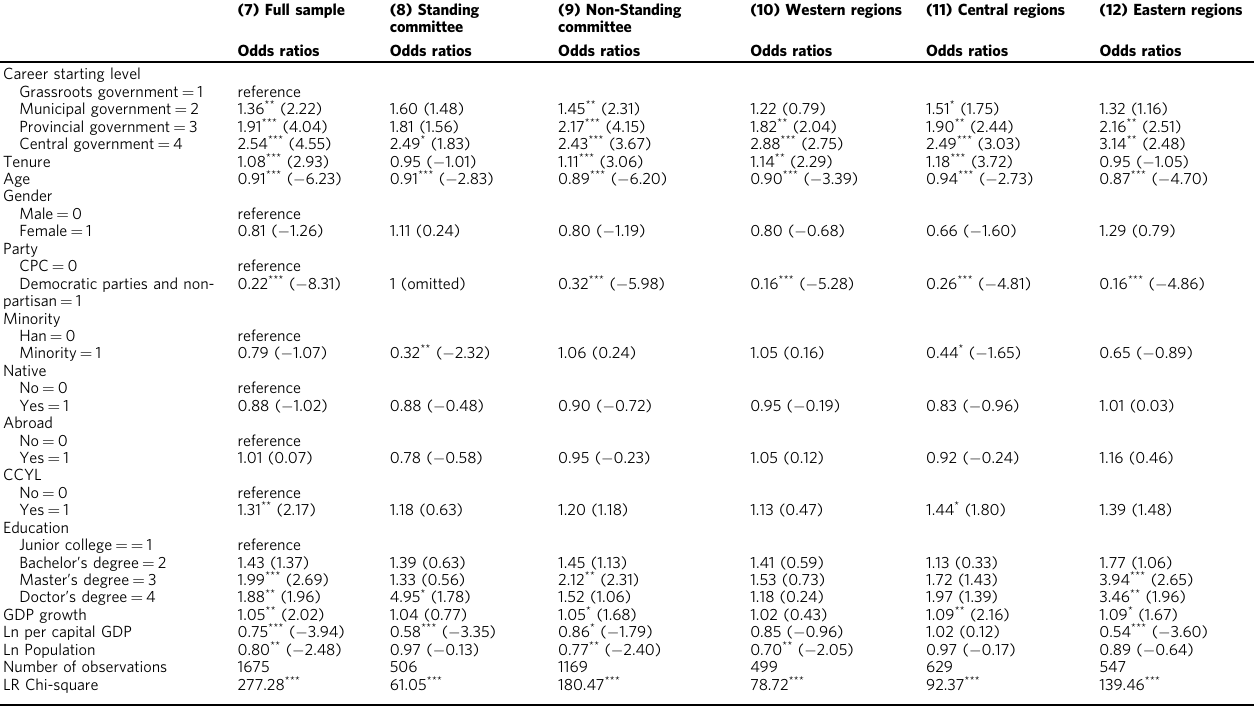
Table 3 The logistic regression results estimating the effect of different career starting levels on political promotion.